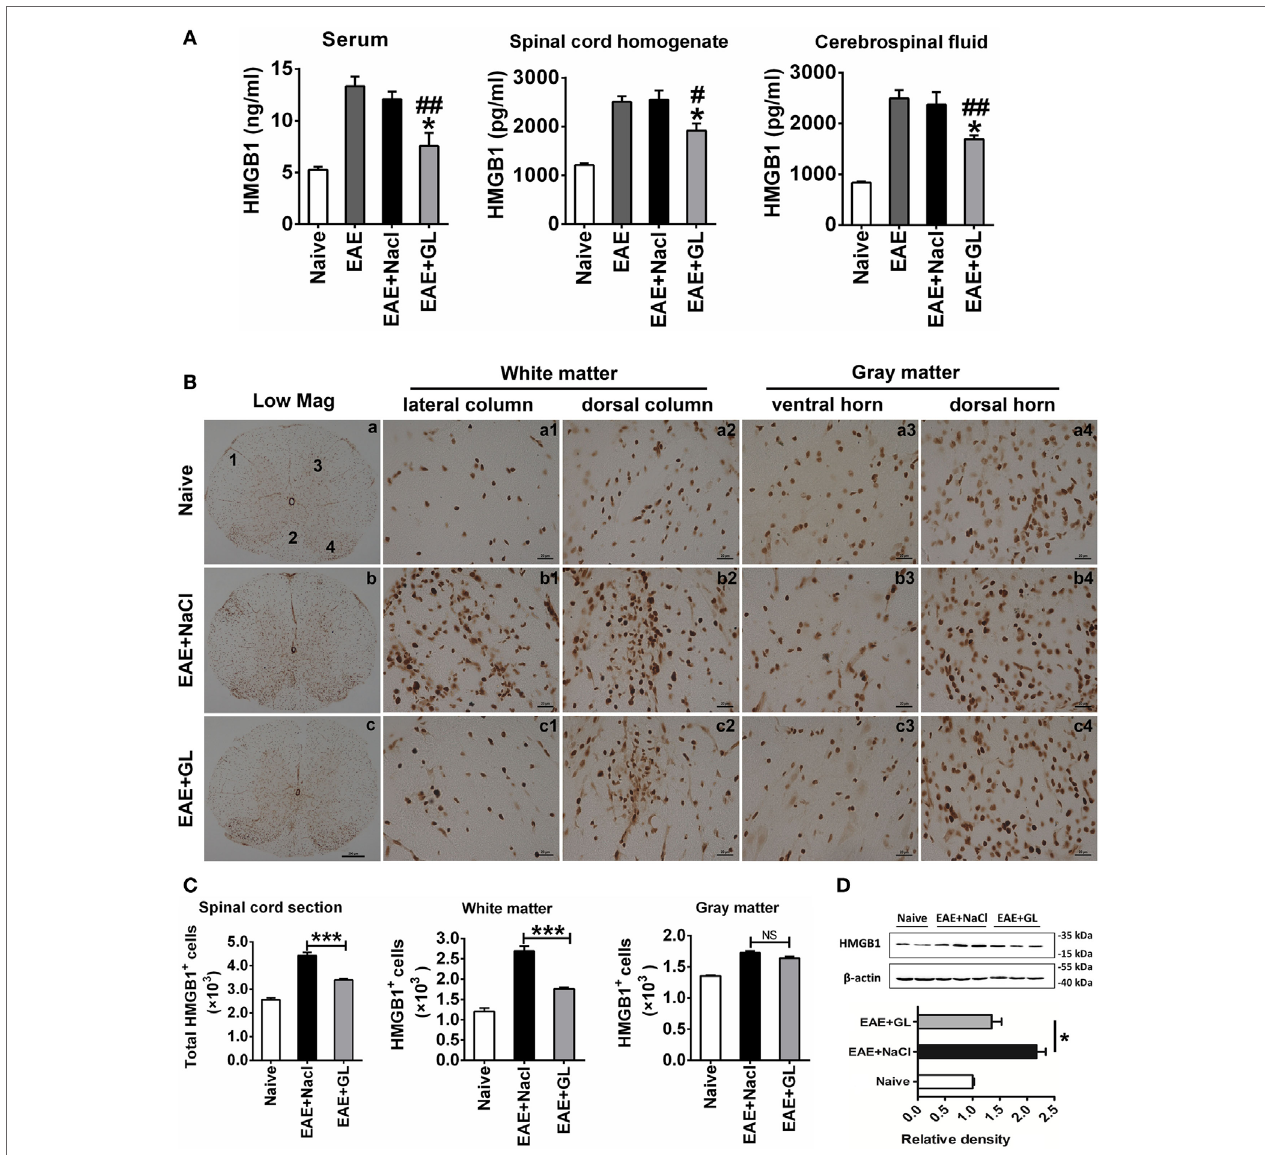
FigUre 4 | The expression and release of high-mobility group box 1 (HMGB1) inhibited by glycyrrhizin (GL) treatment. (a) HMGB1 levels in different body fluids. “Naive,” “experimental autoimmune encephalomyelitis (EAE) + NaCl” and “EAE + GL” mean control group, EAE induction with NaCl treatment group, and EAE induction with GL treatment group, respectively. Data are shown as the mean ± SEM, n = 5–8 for serum and cerebrospinal fluid and n = 6 for spinal cord homogenate in each experimental group. * P < 0.05 vs EAE + NaCl group, # P < 0.05, ## P < 0.01 vs EAE group, using one-way ANOVA followed by Bonferroni’s test. (B) Expression of HMGB1 in thoracic spinal cord sections in naive mice and EAE mice after day 25 treated with either NaCl or GL. 1: lateral column; 2: dorsal column; 3: ventral horn; 4: dorsal horn. Scale bars were 200 µm for low magnification and 20 µm for high magnification. (c) The number of HGMB1-positive cells in one spinal cord section. At least six serial thoracic spinal cord sections were analyzed from each mouse, and six mice were included in each group. Data are expressed as the mean ± SEM. *** P < 0.001 vs EAE + NaCl group; NS, not significant, using one-way ANOVA followed by Bonferroni’s test. (D) Relative densitometry analysis of HMGB1 (25 kDa) normalized to β -actin (43 kDa). Data are shown as the mean ± SEM, n = 4 animals in each experimental group. * P < 0.05 vs EAE + NaCl group, using one-way ANOVA followed by Bonferroni’s test. These data were representative of three independent